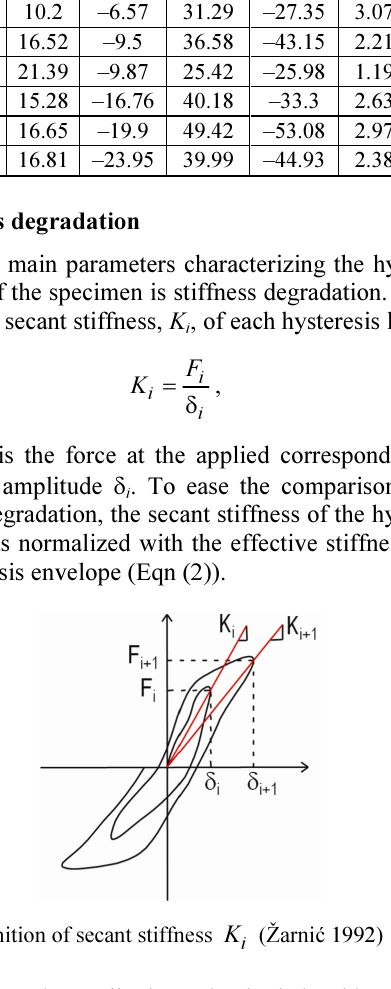
Fig. 7. Definition of secant stiffness i